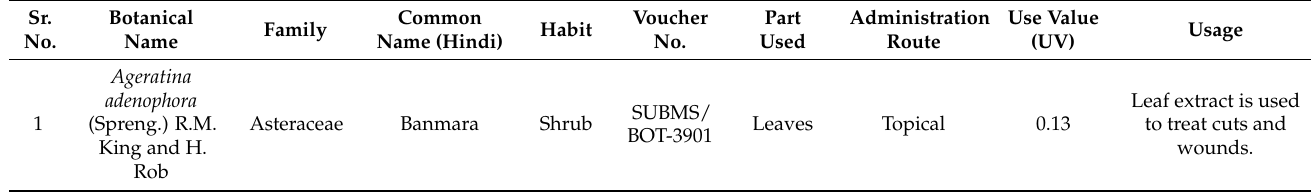
Table 2. Ethnobotanical data documented from the study